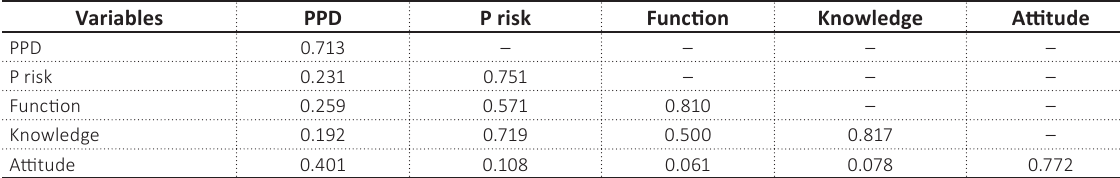
Table 3. Discriminant validity for the measurement